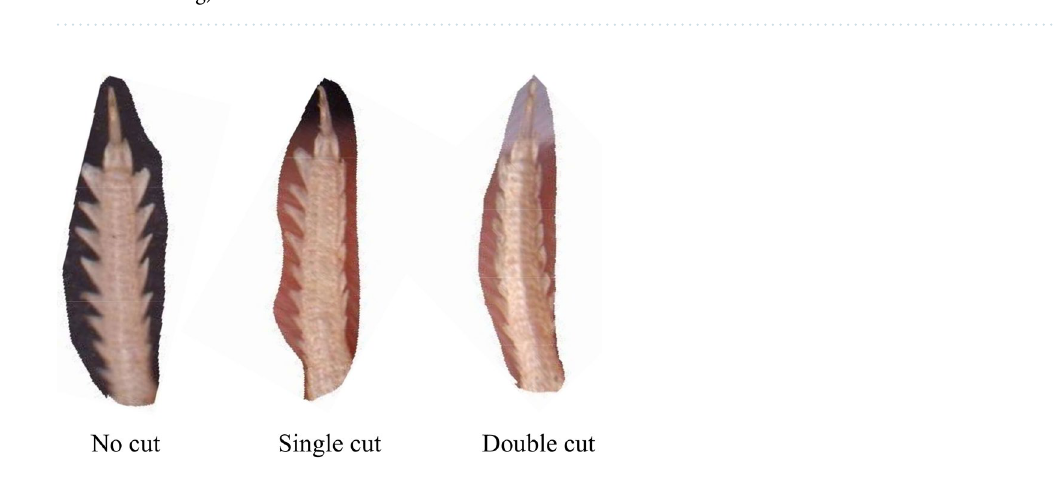
Figure 2. Pictures of fringe under three states (Photo credit: Peng